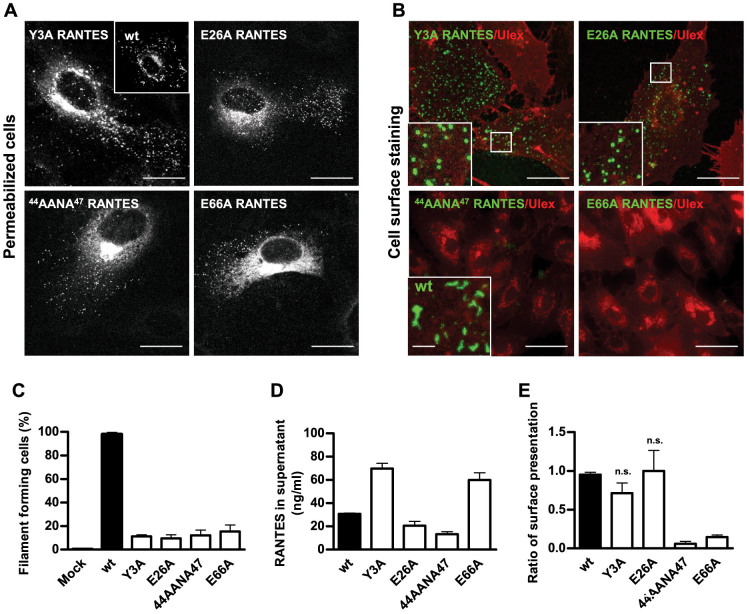
Oligomerization-deficient mutants of RANTES show distinct morphology and
localization compared to the wild type (wt).(A) HUVECs were electroporated with DNA plasmids encoding wtRANTES or
oligomerization-deficient mutants and cultivated for 24 h before
fixation. The cells were permeabilized to label RANTES present
intracellularly and on the surface with rabbit anti-RANTES antibody. Images
were acquired by confocal microscopy. Corner inset shows a cell
electroporated with wtRANTES-encoding plasmid. Scale bars, 10 μm.
(B) The experiment was performed as indicated in A, but labelling was
performed on live HUVECs kept on ice to detect cell surface-associated
RANTES with rabbit anti-RANTES antibody. Labelling with the lectin ulex was
used to visualize individual cells. Images were acquired by sequential
scanning confocal microscopy. Corner insets show high magnification of
framed areas or high magnification of a cell electroporated with DNA
encoding wtRANTES. Scale bars, 10 μm (wt, scale bar =
5 μm). (C) HUVECs were treated as described in A, and the number
of RANTES-positive and filament-forming cells were counted. The graph
presents mean values of percentage of filament-forming cells related to the
total number of RANTES-positive cells. 55–80 cells were evaluated for
each construct in one experiment (n = 3 experiments). Error bars indicate
SEM. The mutants generated a significantly lower percentage of
filament-forming cells than the wt, p < 0.0001. (D) HUVECs electroporated
with DNA encoding the indicated constructs were incubated for 30 h
before supernatants were harvested. The amount of RANTES in supernatants was
quantified by ELISA utilizing recombinant RANTES as standard. The mutants
were present in amounts that differed significantly from the wt, p <
0.0001. Error bars indicate SEM, n = 3–6 experiments. (E) HUVECs were
treated as indicated in A, but half of the samples were kept live on ice
during labelling to indicate cell surface-associated RANTES. Labelling with
ulex was used to visualize individual cells. The graph shows mean values of
the percentage of filament forming-cells related to the total number of
RANTES-positive cells. 55–80 cells were evaluated for each construct
in one experiment (n = 3 experiments). Error bars indicate SEM. Surface
presentation of 44AANA47 and E66A differed
significantly from that of the wt, p < 0.0001. n.s., not significant.